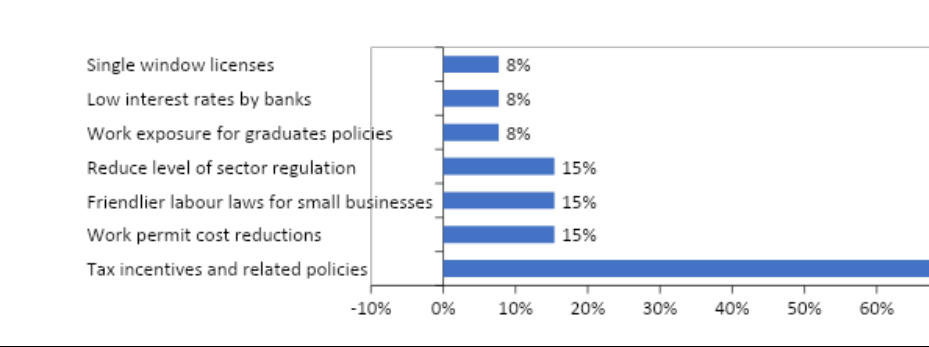
Figure 20: Suggestions on improving the